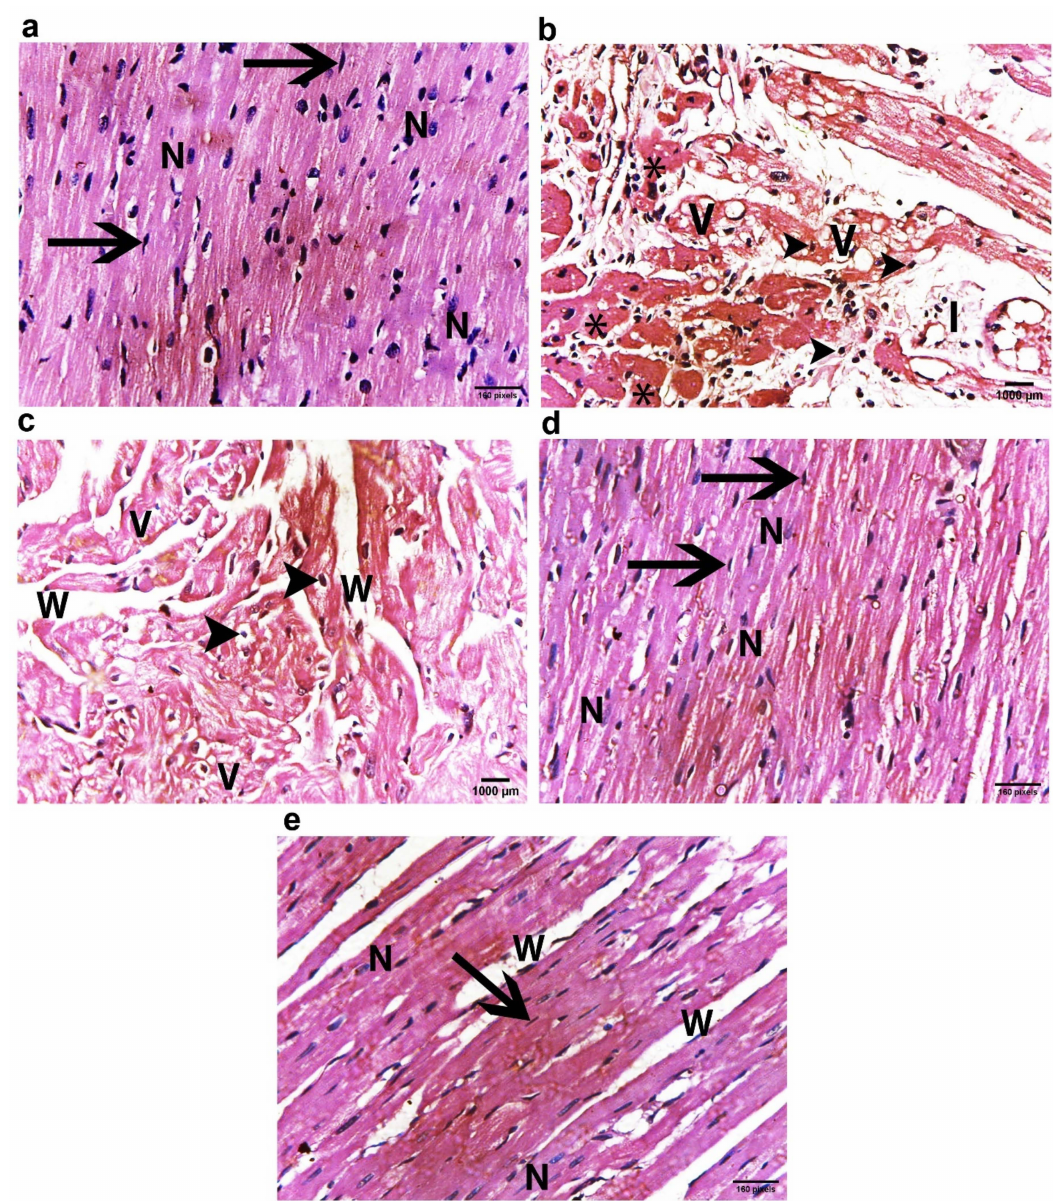
Figure 10. Representative photomicrographs of hematoxylin- and eosin-stained sections from the left ventricular myocardium in the different experimental groups: ( a ) Group I (control group) showed anastomosing and branching cardiac muscle fibers. The cardiomyocytes displayed central vesicular oval nuclei (N) and acidophilic cytoplasm. The flat dark nuclei (arrow) of the endomysium connective tissue fibroblasts are shown; ( b ) Group IIa (DOX/Trz group) showed disrupted and separated myofibers with intracytoplasmic vacuolization (V), hyaline degeneration, and Zenker’s necrosis (*) and pyknosis (arrowhead) of many cardiomyocyte nuclei. Notice the accumulation of inflammatory cells (I) among the myofibers; ( c ) Group IIb (recovery group) showed separated, thinly stretched myofibers with the absence of striation (W), cytoplasmic vacuolization (V), and pyknosis (arrowhead) of numerous cardiomyocyte nuclei; ( d ) Group III (prophylactic group) showed a nearly normal histological architecture, with acidophilic cytoplasm and vesicular, oval centrally located nuclei (N). Notice the regularly arranged muscle fibers with narrow spacing; and ( e ) Group IV (curative group) showed slightly disorganized cardiac muscle fibers with slight narrow spacing between the myofibers (W); n =